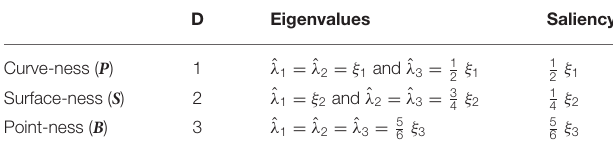
TABLE 2 | Expected eigenvalues and saliencies in the case of a uniform density in a D -hyperball, which can be interpreted as density measures and allow to control the density of each geometric primitive.